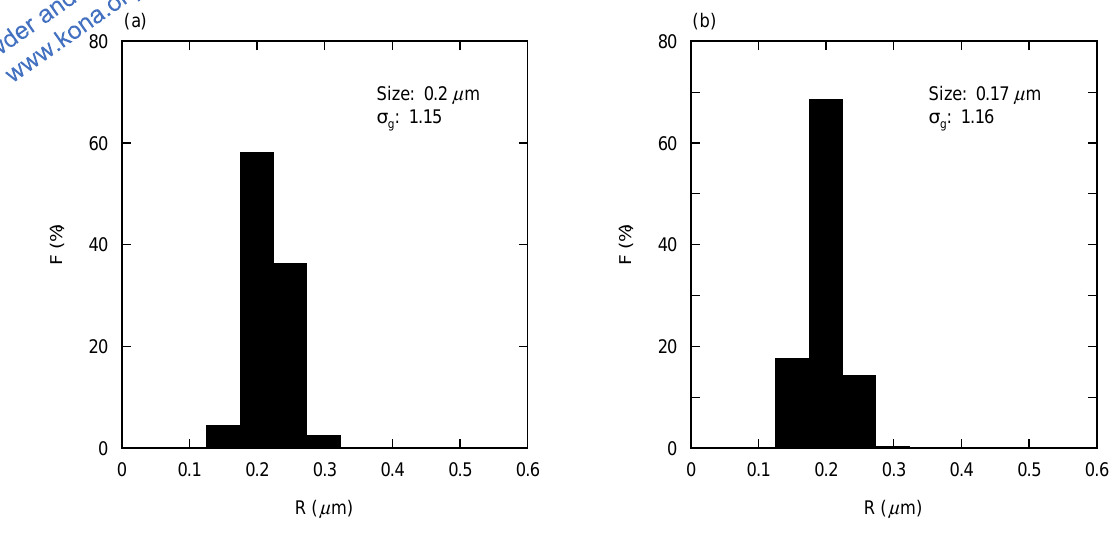
Fig. 4 Particle size distribution of monodispersed alumina particles prepared with a C-T flow reactor (a) and a batch reactor